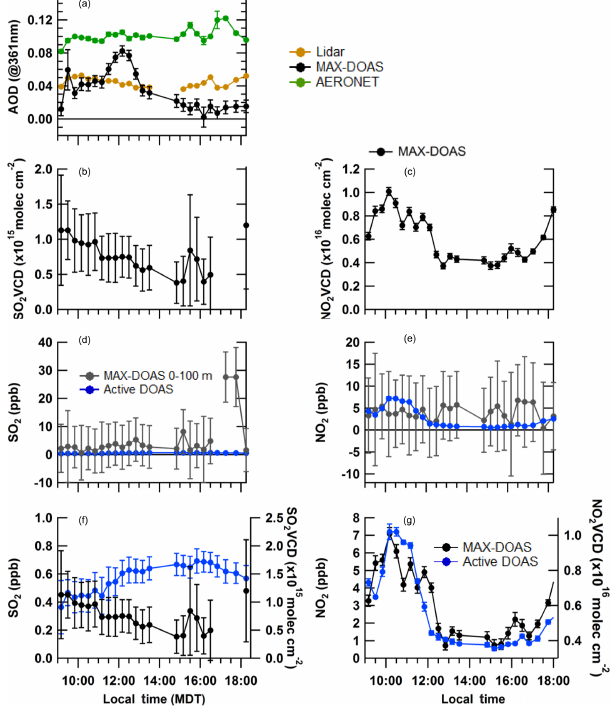
Figure 9. The 7 September AODs from MAX-DOAS, lidar, and AERONET (a) ; MAX-DOAS and Pandora SO 2 VCDs (b) ; MAX- DOAS and Pandora NO 2 VCDs (c) ; MAX-DOAS 0–100m and ac- tive DOAS SO 2 mixing ratios (d) ; MAX-DOAS 0–100m and ac- tive DOAS NO 2 mixing ratios (e) ; MAX-DOAS VCDs and active DOAS mixing ratios of SO 2 (f) ; and MAX-DOAS VCDs and ac- tive DOAS mixing ratios of NO 2 (g) . MAX-DOAS error bars were obtained from the optimal estimation retrieval. Error bars on the li- dar and AERONET AODs are the standard error of the temporally averaged values. Error bars on the Pandora VCDs and active DOAS mixing ratios are root-sum-square errors of the standard error from averaging and instrumental precision and the DOASIS retrieval er- ror, respectively. See Sect. 2.3.3 for details.